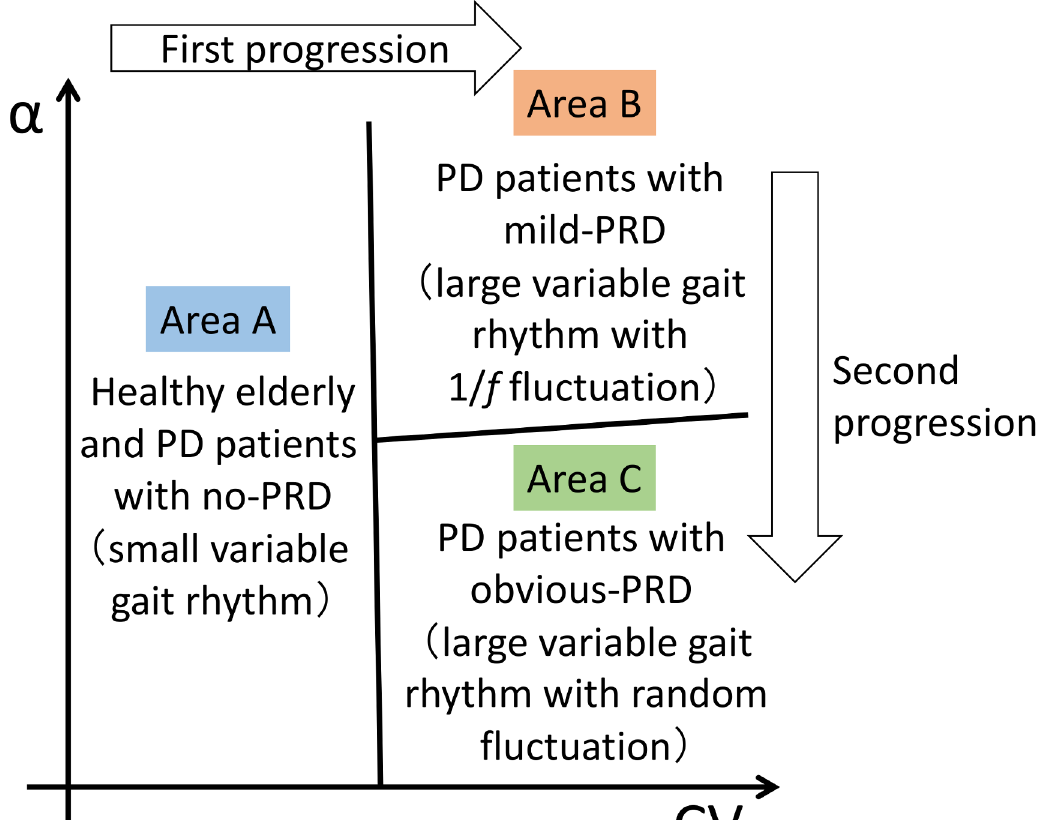
Figure 5. Concept of the evaluation platform. The x-axis is related to the CV of the stride interval, and the y-axis is related to the a of the stride interval. PRD, postural reflex disorder.